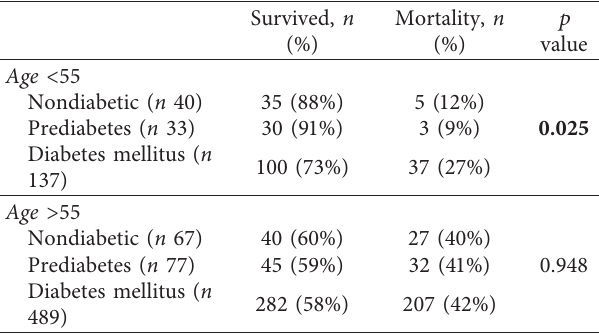
Table 4: Comparison of mortality based on the age group.